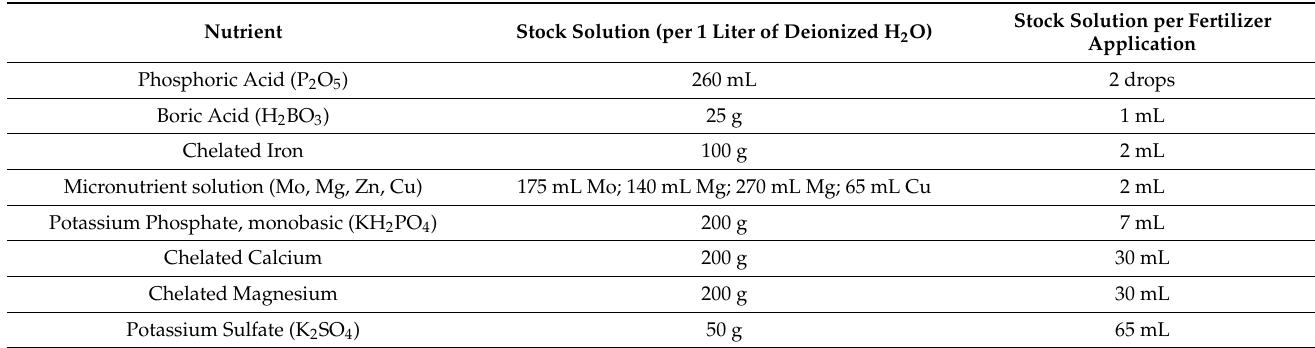
Table A1. Complete recipe of fertilization